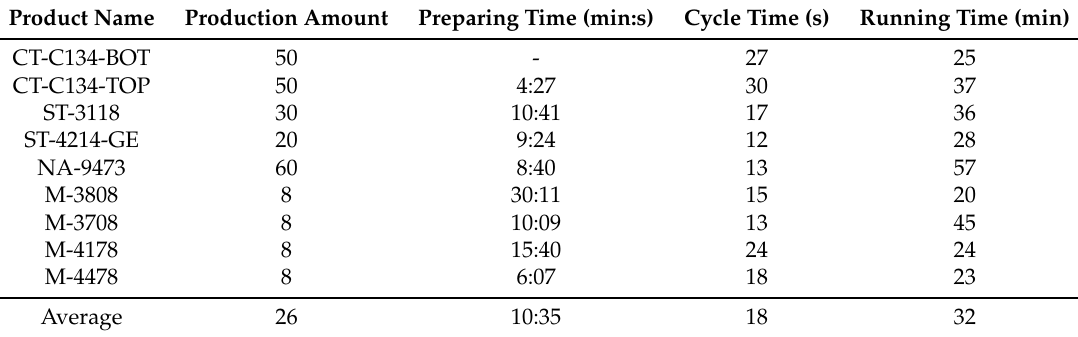
Table 1. Daily record of the manufacturing process on 24 April